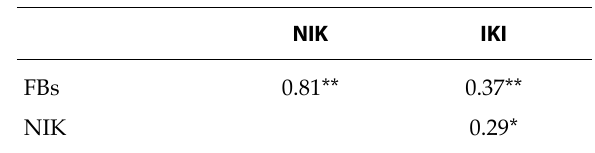
Table 3. Simple correlation coefficients (r) among FBs con- tent, number of infected kernels (NIK) and internal kernel infection (IKI) in maize inbred lines inoculated with F. ver- ticillioides in 2009 and 2010 (n= 66).